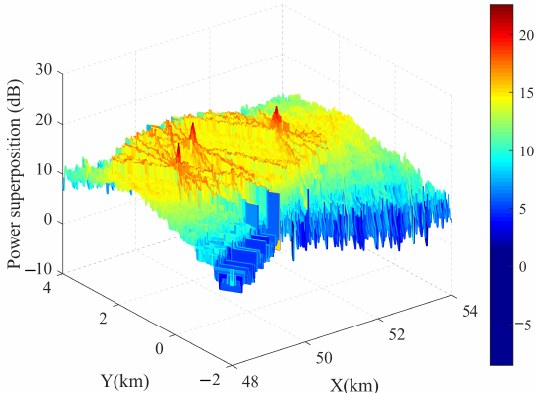
Figure 5. Energy accumulation within common surveillance region and κ = 4 and SNR = 2 dB.